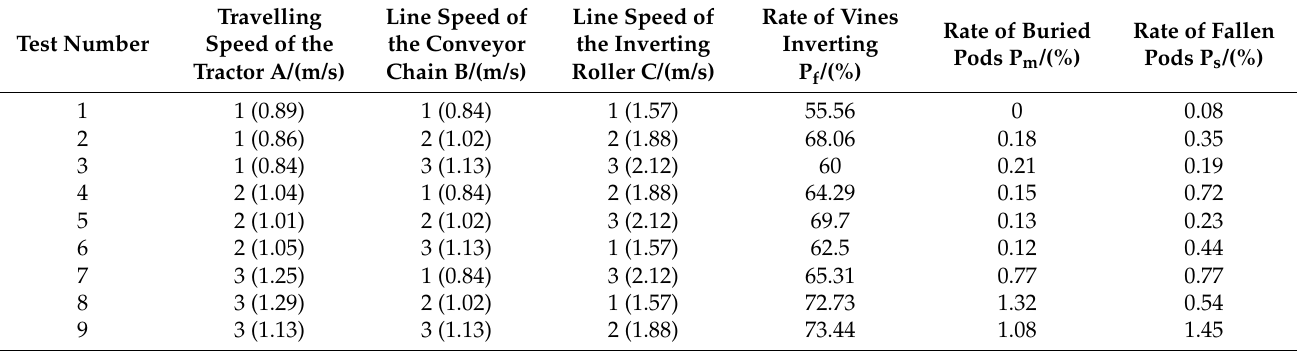
Table 3. Experimental design and results of unpressed vines.